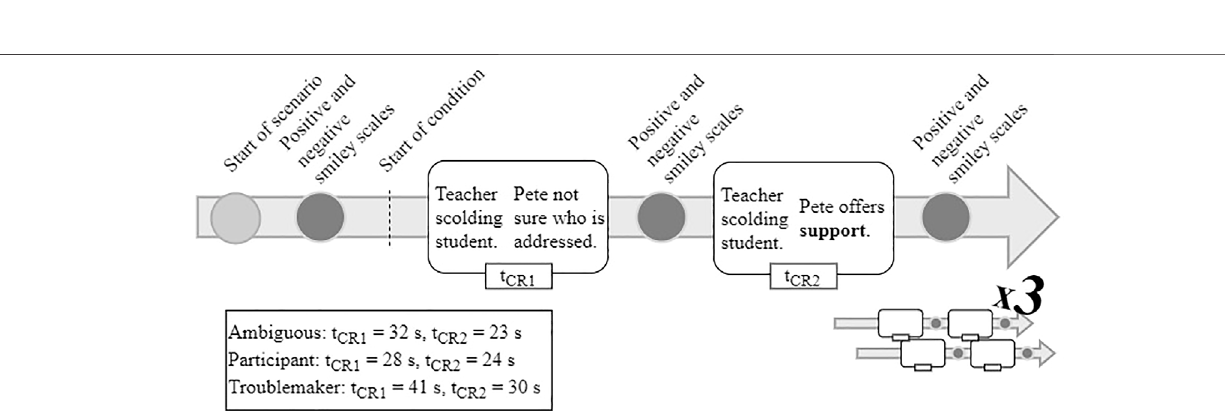
Frontiers in Virtual Reality |